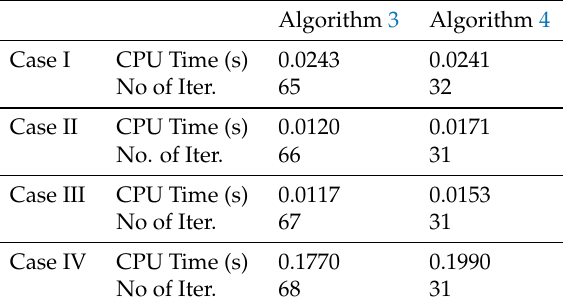
Table 1. Numerical results for Example